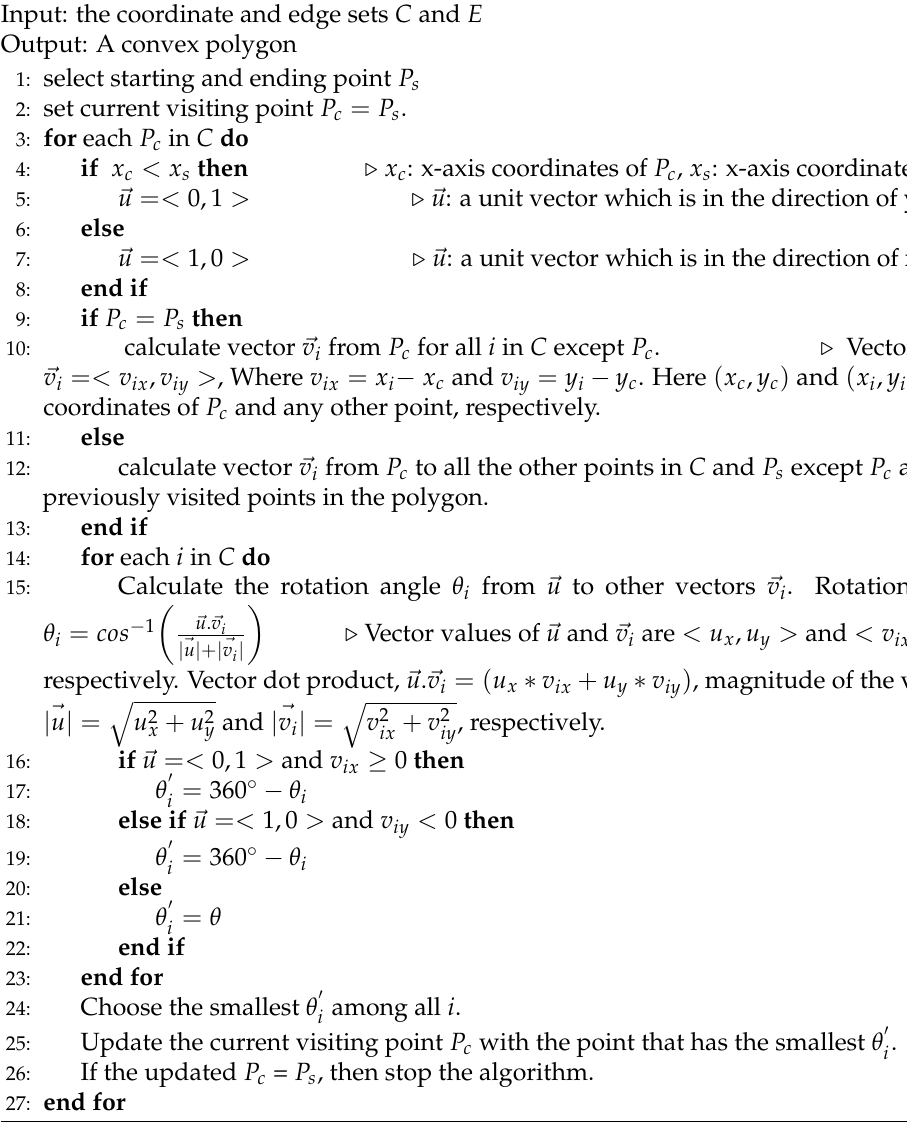
Algorithm 1 Vector rotation angle-based obstacle avoidance (VRAOA)